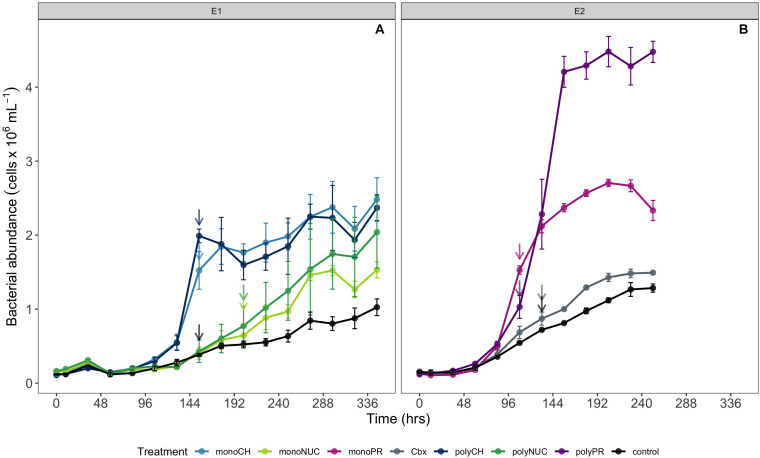
Microbial community growth dynamics during incubations determined by flow cytometry (A) experiment 1 and (B) experiment 2. Cell counts are shown as averages of biological triplicates ± standard deviation (SD) × 106 obtained in experiment 1 (A) and 2 (B). Arrows indicate the time points when samples for metatranscriptomics were taken. Samples for metatranscriptomic analysis were retrieved after 108 h (monoPR, amino acids; and polyPR, polypeptides), 132 h (Cbx, carboxylic acids; and contTwo, control from experiment 2), 154 h (monoCH, monosaccharides; polyCH, polysaccharides; and contOne, control from experiment 1), and 202 h (monoNUC, nucleotides; and polyNUC, DNA).